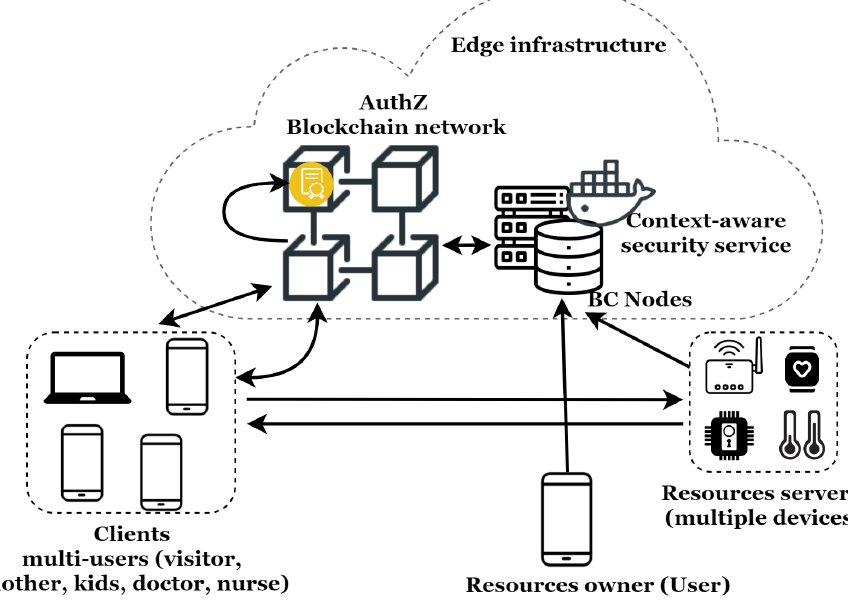
Figure 4. Blockchain-enabled decentralized context-aware authorization management architecture in the